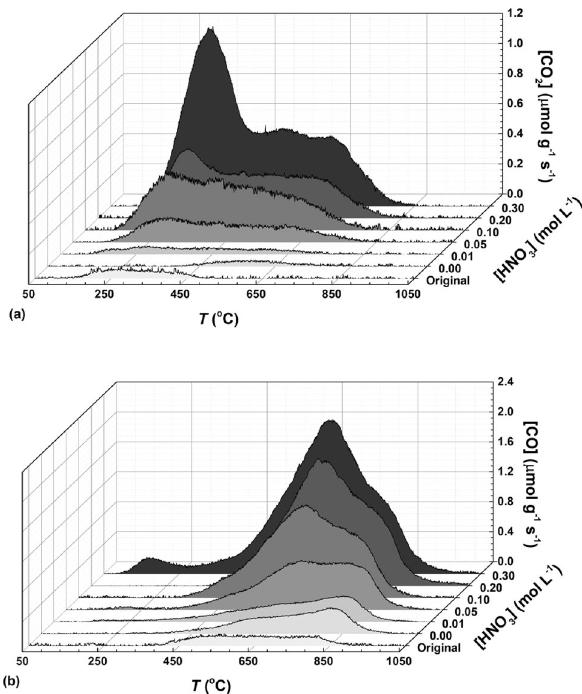
Figure 1. TPD spectra of CXs subjected to hydrothermal treatment with different HNO 3 concentrations: ( a ) CO 2 and ( b ) CO evolution with temperature (this figure was produced using OriginPro 9.0.0 software, OriginLab Corporation; http:// www. Origi nLab.